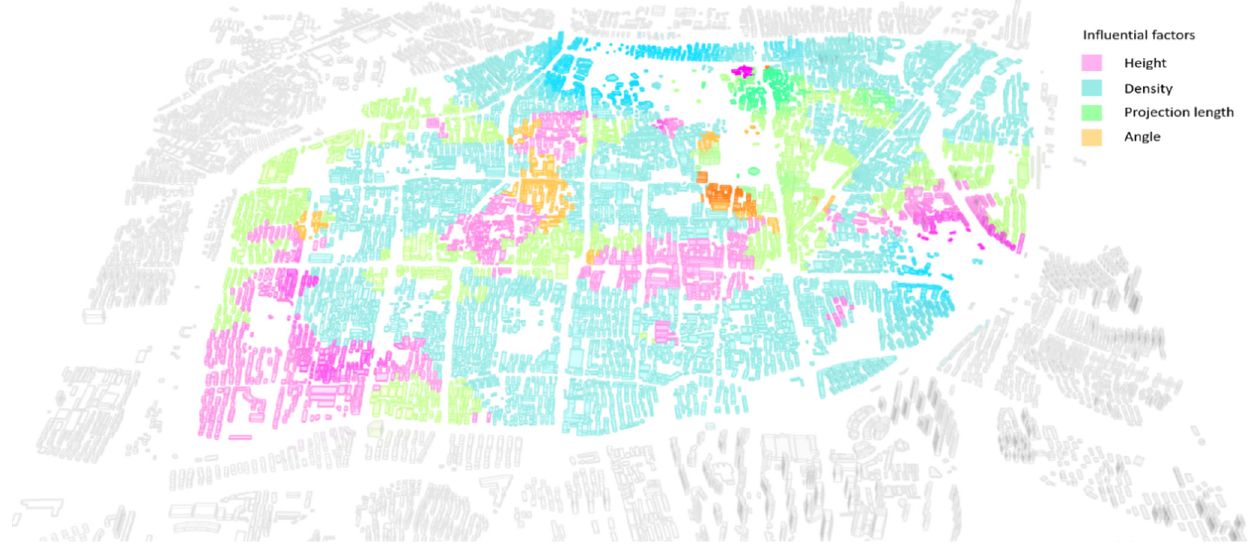
Figure 7. Influential areas and relative intervention methods.